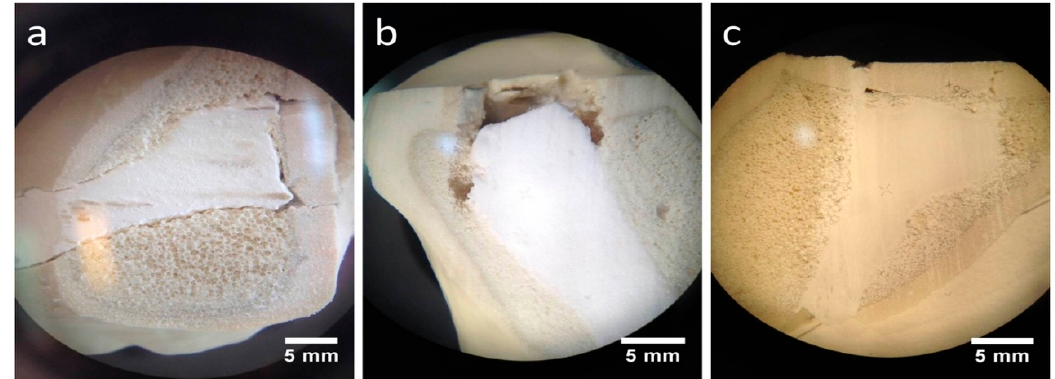
Figure 10. Stereomicroscopic images. Better interdigitation of the humid CPC and seamless interdigitation of the MPC: Regarding augmented tibial head depression fractures under a stereomicroscope, a low interdigitation with a visible gap to the spongiosa could be seen for the CPC when stored under dry conditions ( a ). In contrast, under humid storage conditions, the interdigitation for the same cement seemed to improve remarkably, showing no gap ( b ). A full interdigitation to the nearby spongiosa up to the reduced fracture fragment was detected for the MPC ( c ).